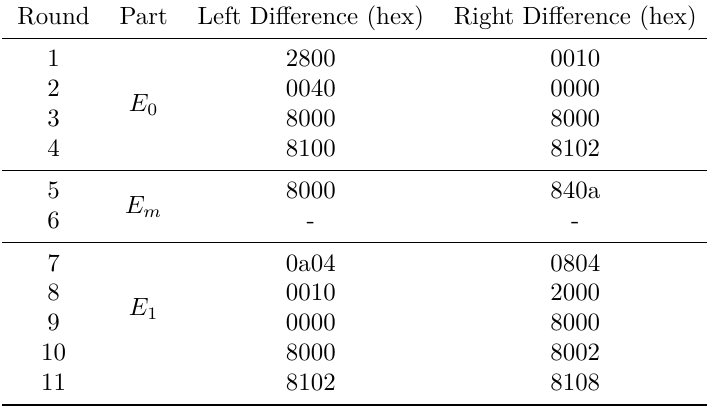
Table 6: A Boomerang Characteristic for SPECK32/64.